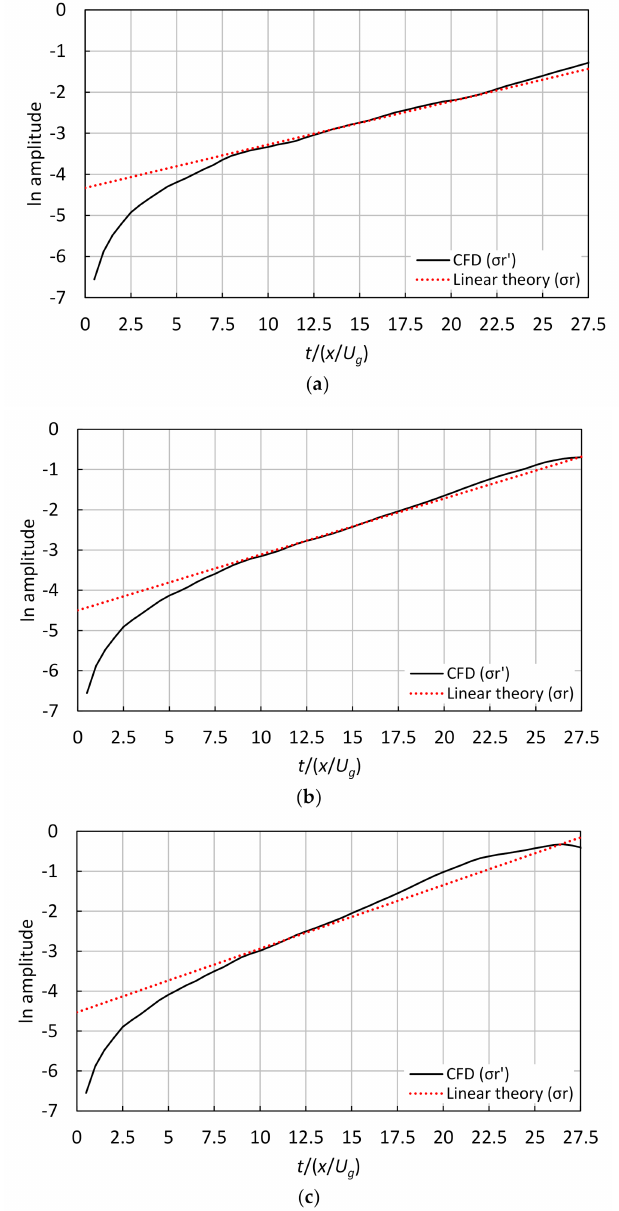
Figure 5. Time variation of the natural logarithm of the disturbance amplitude for different gas Weber numbers ( We g ), in the case of 3000 ( X direction) × 400 ( Y direction) cells and with C α = 0: ( a ) We g = 1.7, ( b ) We g = 2, and ( c ) We g =